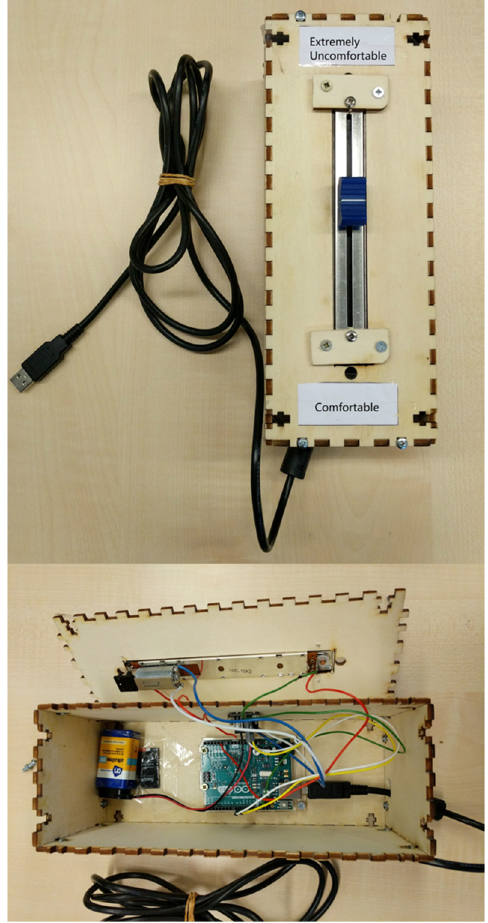
Figure 3. Feeling-of-uncomfortable slider.